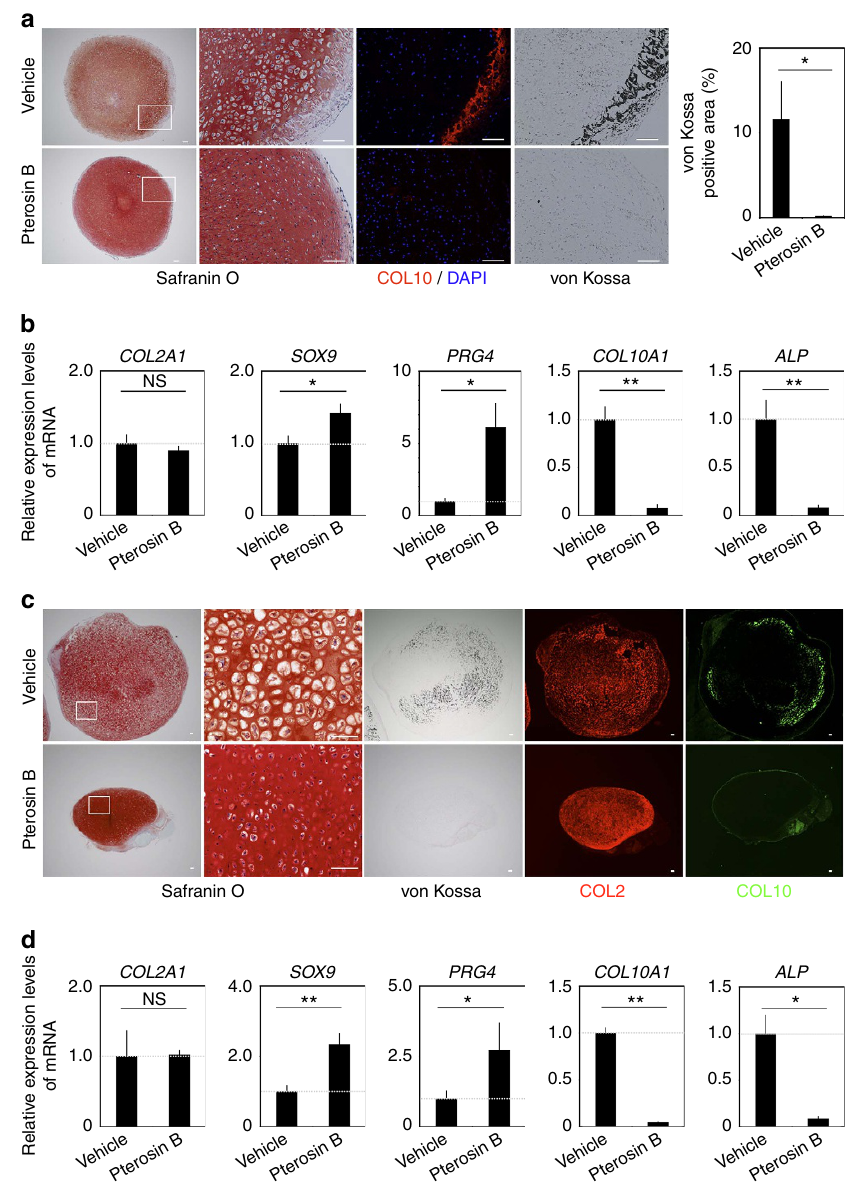
Figure 5 | Effects of pterosin B on human articular chondrocytes and hiPSC-derived chondrocytes. ( a ) Semiserial histological sections of cultured pellets of human articular cartilage in the presence or absence of 300 m M pterosin B were stained with safranin O-fast green-iron haematoxylin and von Kossa and immunostained for COL10. Boxed regions in the left panels are shown in the right. Area of von Kossa-positive regions per total area of pellets are shown; n ¼ 3 pellets. ( b ) Real-time RT–PCR expression analysis of marker genes in pellet culture of human articular chondrocytes in the presence or absence of 300 m M pterosin B; n ¼ 3 pellets. ( c ) Semiserial histological sections of hiPSC-derived cartilage particles treated with or without 300 m M pterosin B were stained with safranin O-fast green-iron haematoxylin and von Kossa and immunostained for COL2 and COL10. Boxed regions in the left panels are shown in the right. The images are representative of three pellets each. ( d ) Real-time RT–PCR expression analysis of marker genes in hiPSC-derived cartilage particles in the presence or absence of 300 m M pterosin B; n ¼ 3 pellets. Error bars denote means ± s.d. * P o 0.05, ** P o 0.01 and NS, not significantly different by the t -test. Scale bars, 100 m